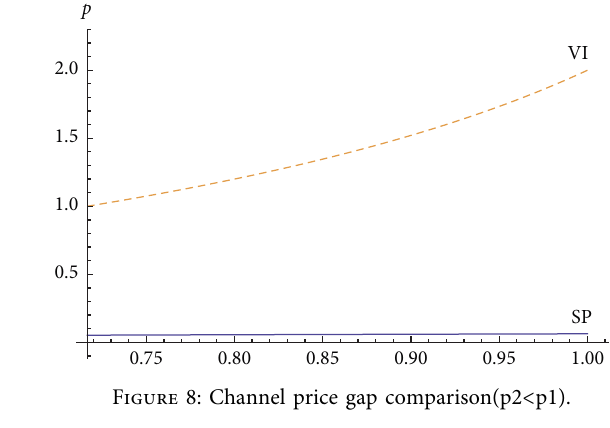
Figure 8: Channel price gap comparison(p2 < p1).